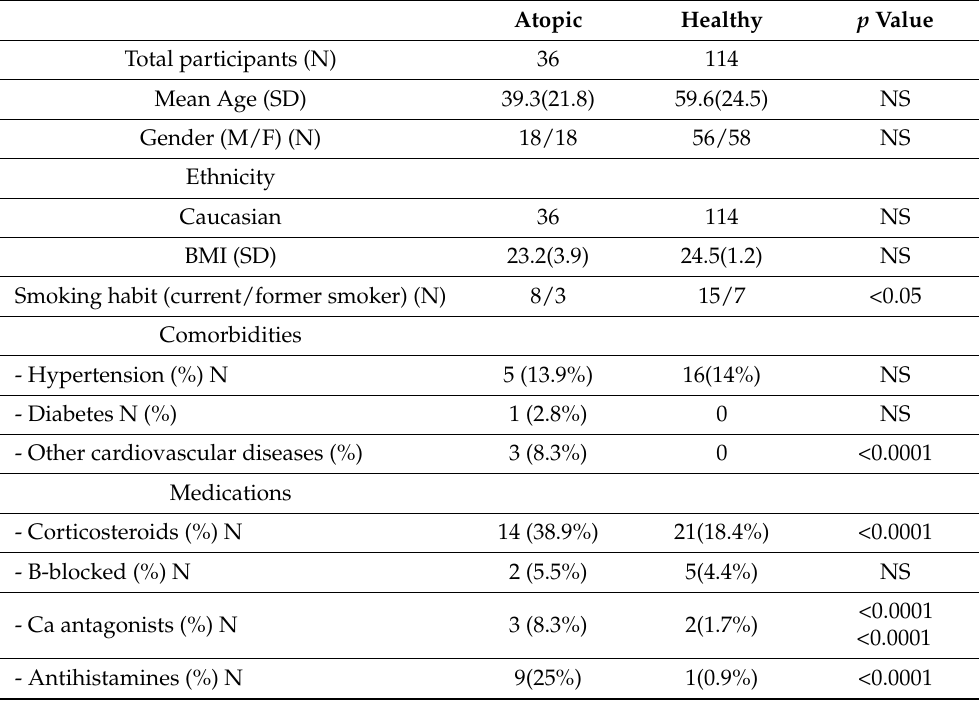
Table 1. Demographic characteristics and pharmacological treatments of enrolled subjects. Results were shown as means ± SD. The statistical tests used in these analyses were the one-way analysis of variance followed by the Tukey Multiple Comparison Test. NS = not significant.